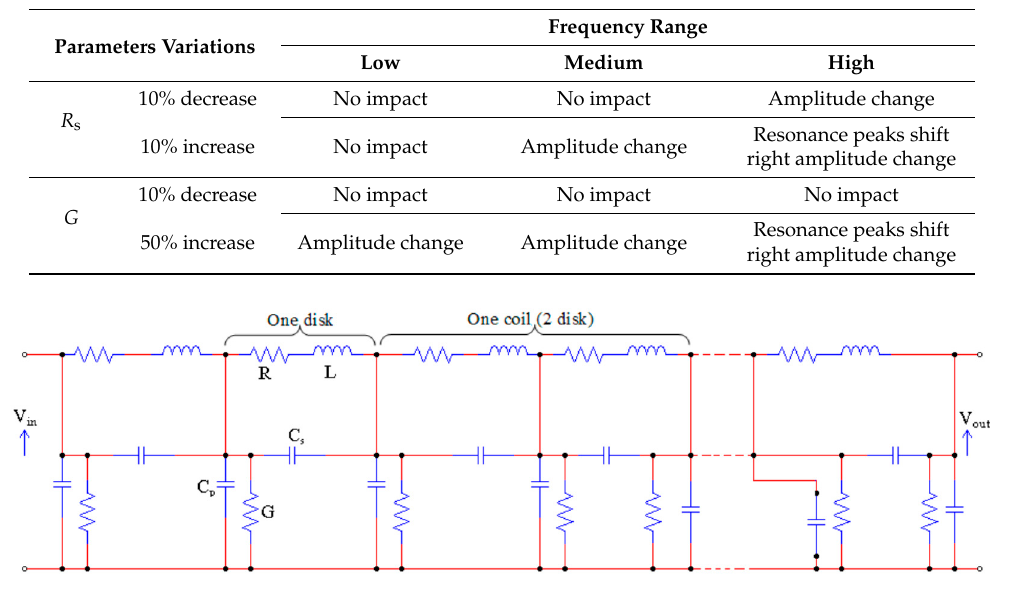
Figure 4. Transformer distributed parameters model [19].